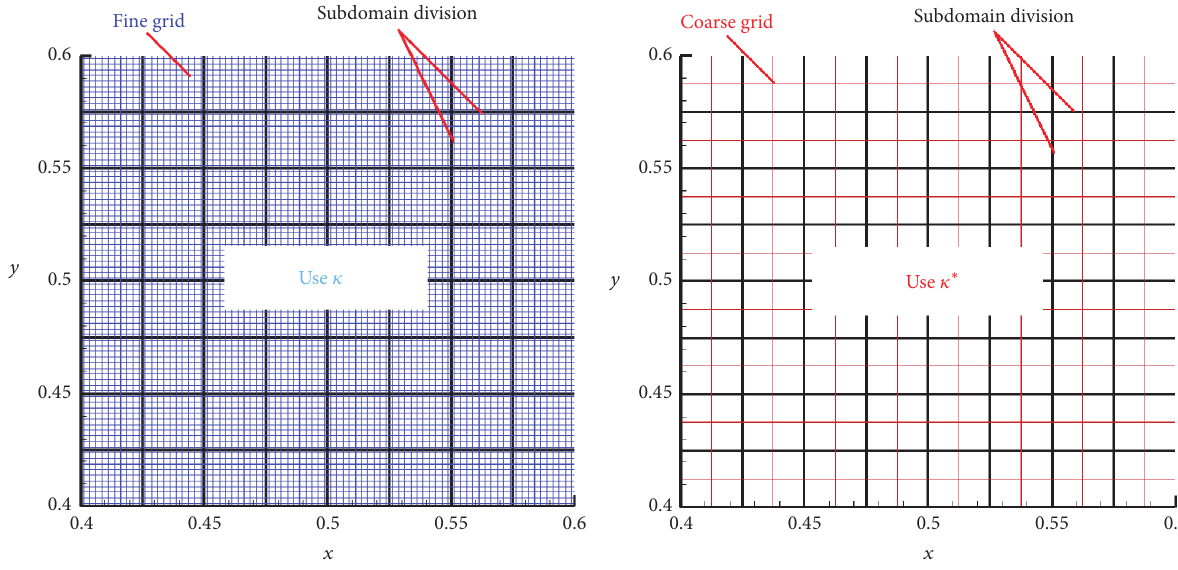
Figure 1: Schematic models of the fine and coarse